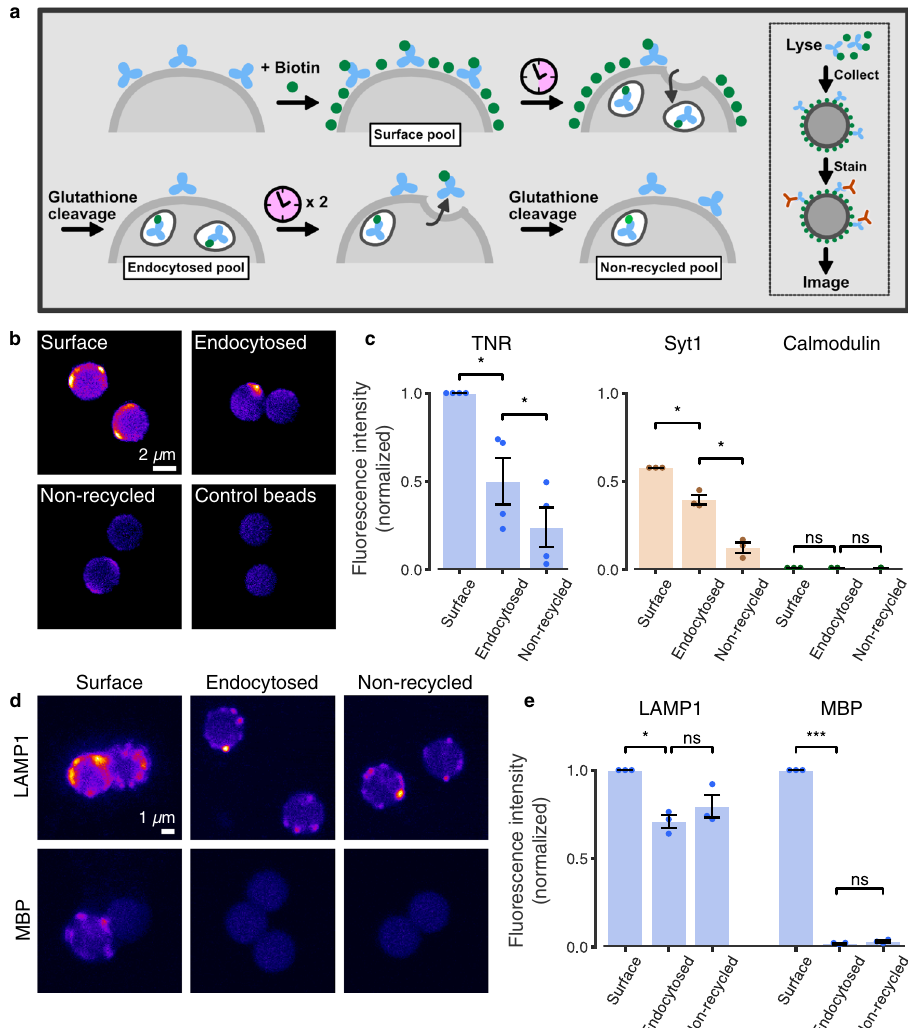
Fig. 1 TNR molecules endocytose and subsequently resurface in neurons. a Neurons were treated with sulfo-NHS-S-S-biotin to label cell-surface proteins. Following a 6-h incubation, allowing for internalization, remaining cell-surface proteins were stripped of their labels with glutathione. After a further 18 h of incubation, allowing for recycling, the neurons were again treated with glutathione. Lysates representing surface, endocytosed or non- recycled pools, were collected on streptavidin-coupled beads, immunostained for TNR, immobilized on glass slides and imaged with confocal microscopy. b Example beads collecting TNR pools, or controls incubated without primary antibodies. Scale bar = 2 µ m. c A quanti fi cation of TNR fl uorescence intensity normalized to the ‘ surface ’ mean in the corresponding experiment, indicates that a large fraction of TNR molecules endocytose within 6 h, and many subsequently resurface within 24 h. As positive/negative controls, the synaptic vesicle protein Syt1, well-known to recycle, and the intracellular protein calmodulin were tested. The plots are scaled by the ratio between the ‘ surface ’ mean for these proteins and that of TNR. N = 4 (TNR) and 3 (Syt1/ calmodulin) independent experiments with >100 (TNR) and >50 (Syt/calmodulin) beads. d , e As additional controls, the lysosomal marker LAMP1, known to endocytose but scarcely recycle, and myelin basic protein (MBP), which should not endocytose, were also tested. Scale bar = 1 μ m. e Quanti fi cation of LAMP1/MBP fl uorescence intensity, normalized to the ‘ surface ’ mean of the corresponding experiment. N = 3 independent experiments with > 50 beads. Statistical signi fi cance was evaluated using repeated-measures one-way ANOVA, ( c TNR: F 1.153,3.458 = 28.29, ** p = 0.009; Syt1: F 1.007,2.014 = 62.98, * p = 0.015; calmodulin: F 1,2 = 0.016, p = 0.912; e LAMP1: F 1.293,2.585 = 19.6, * p = 0.028; MBP: F 1.52,3.041 = 28337, *** p < 0.001), followed by the Holm-Sidak multiple comparisons test comparing ‘ surface ’ / ‘ endocytosed ’ and ‘ endocytosed ’ / ‘ non-recycled ’ ( c TNR: * p = 0.032, * p = 0.021; Syt1: *p = 0.044, * p = 0.044; calmodulin: p = 0.933, p = 0.993; e LAMP1: *p = 0.045, p = 0.162; MBP: *** p < 0.001, p = 0.068). Data represent the mean ± SEM, dots indicate individual experiments. Source data are provided in Source Data fi